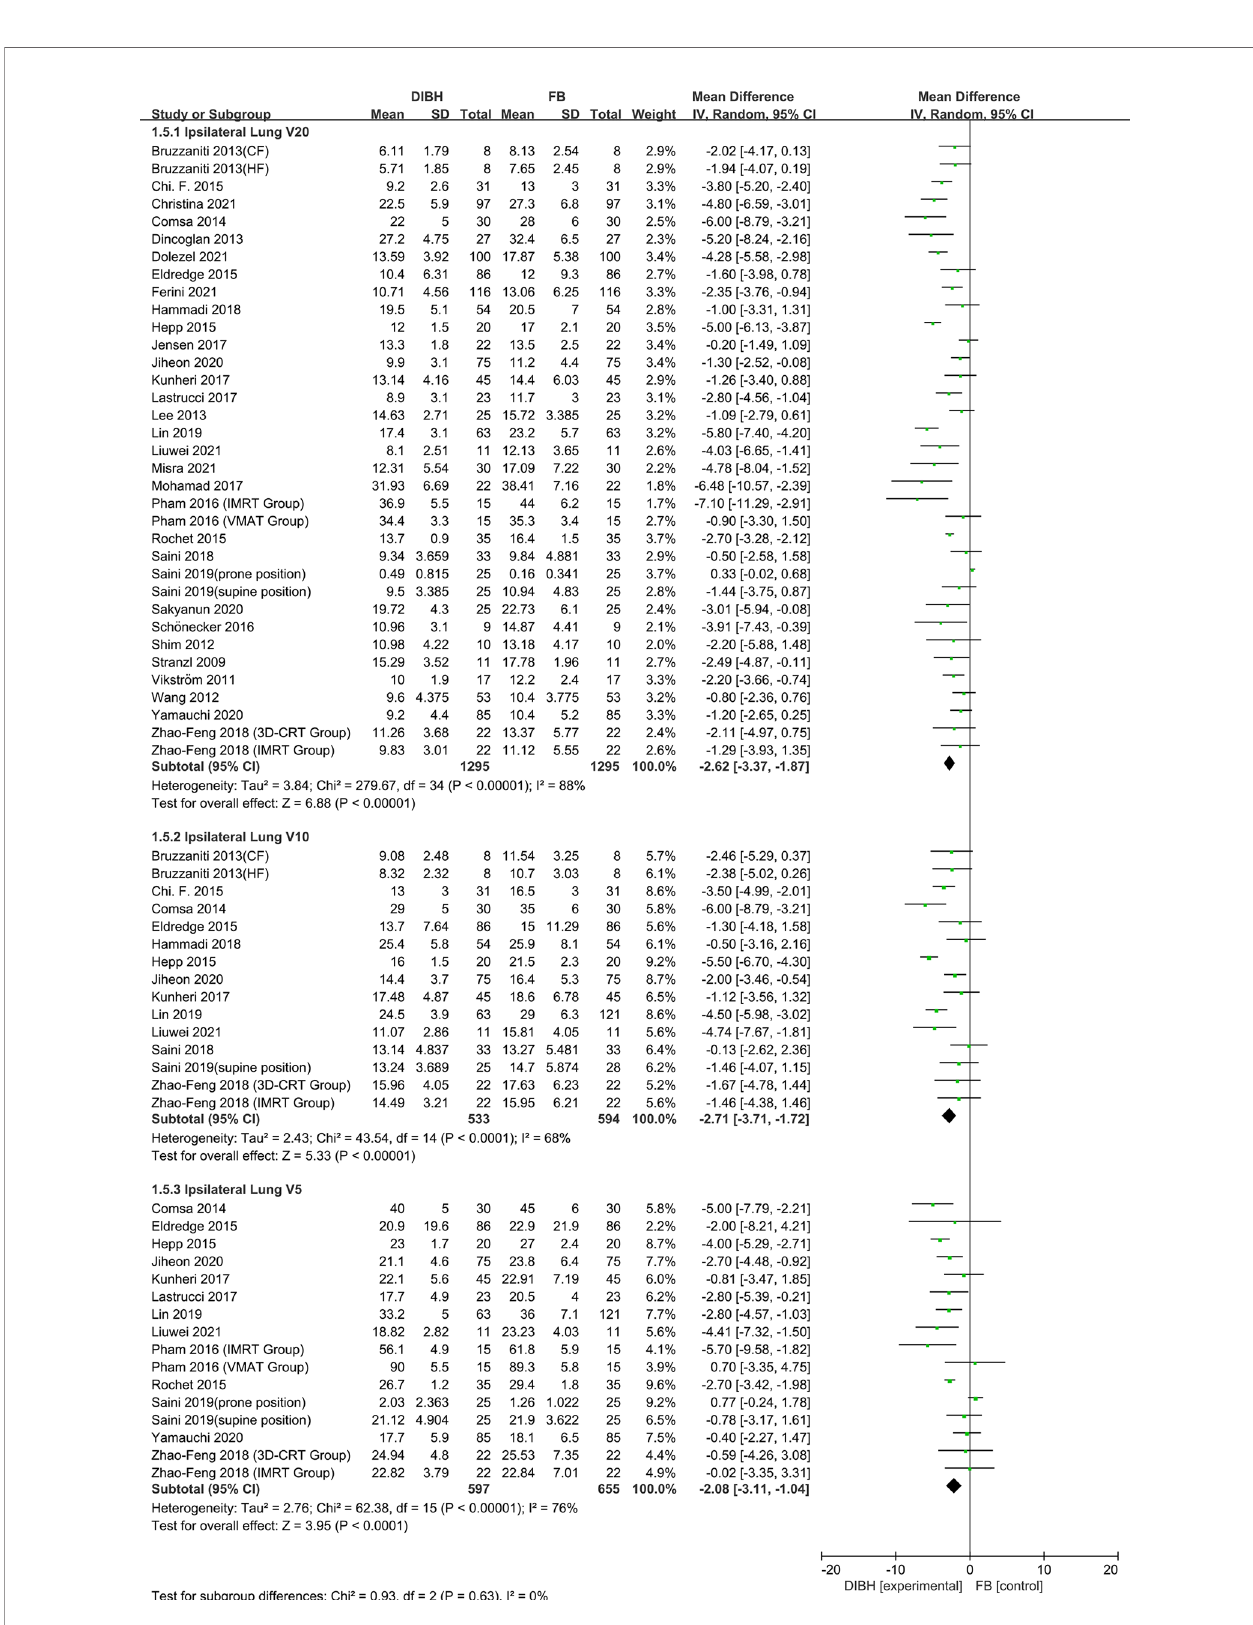
FIGURE 6 | Forest plot of ipsilateral lung dose (V20, V10 and V5) between the DIBH group and FB